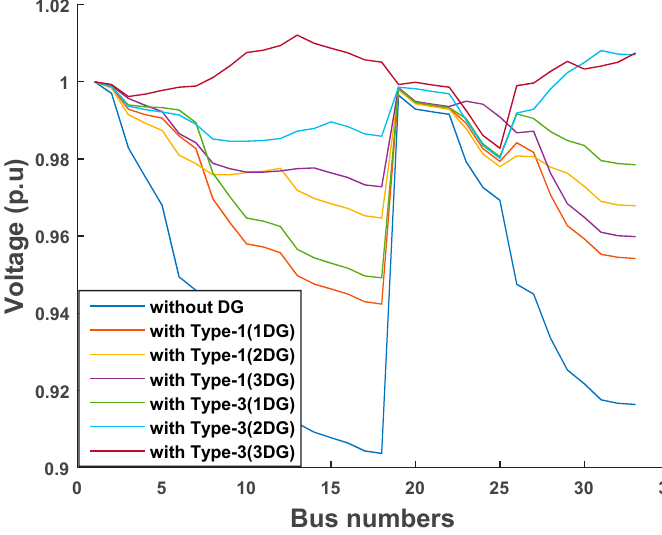
Figure 7. Voltage profile for 33 bus with Type-1 and Type-3 DG for 1st objective function.